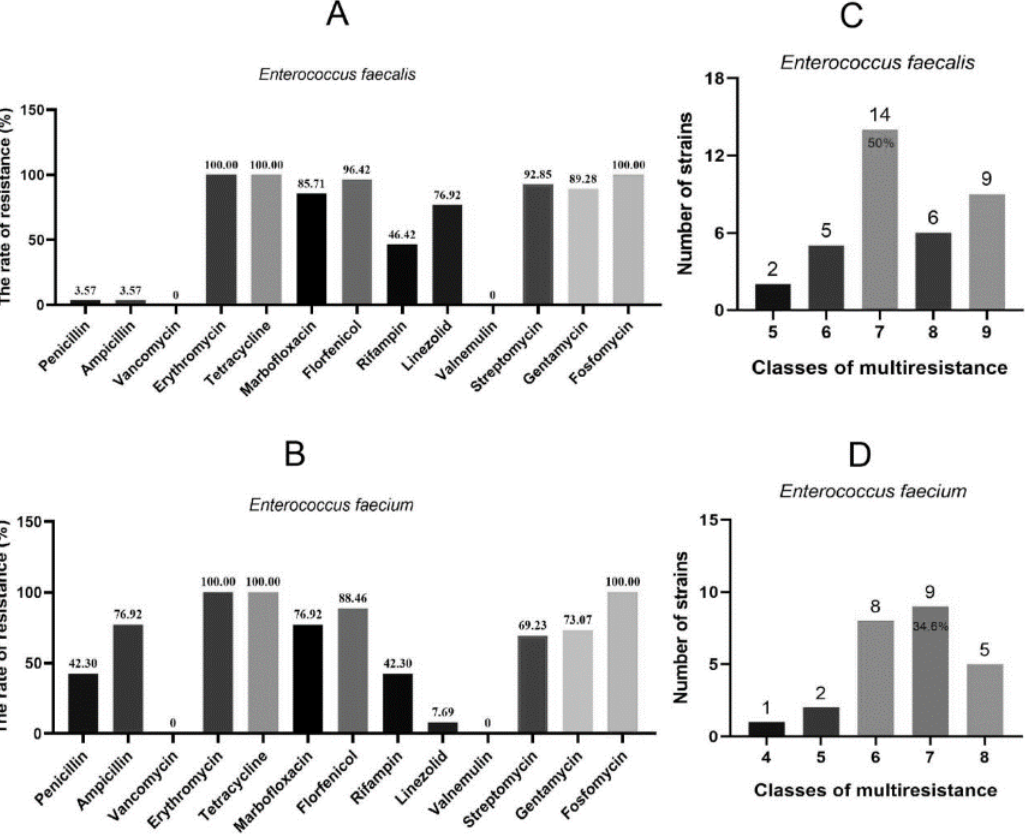
Figure 1. Antimicrobial resistant profiles of FRE strains. A and B, the antibiotic-resistance rate of each tested drug; C and D, the proportion of multiresistance FRE.